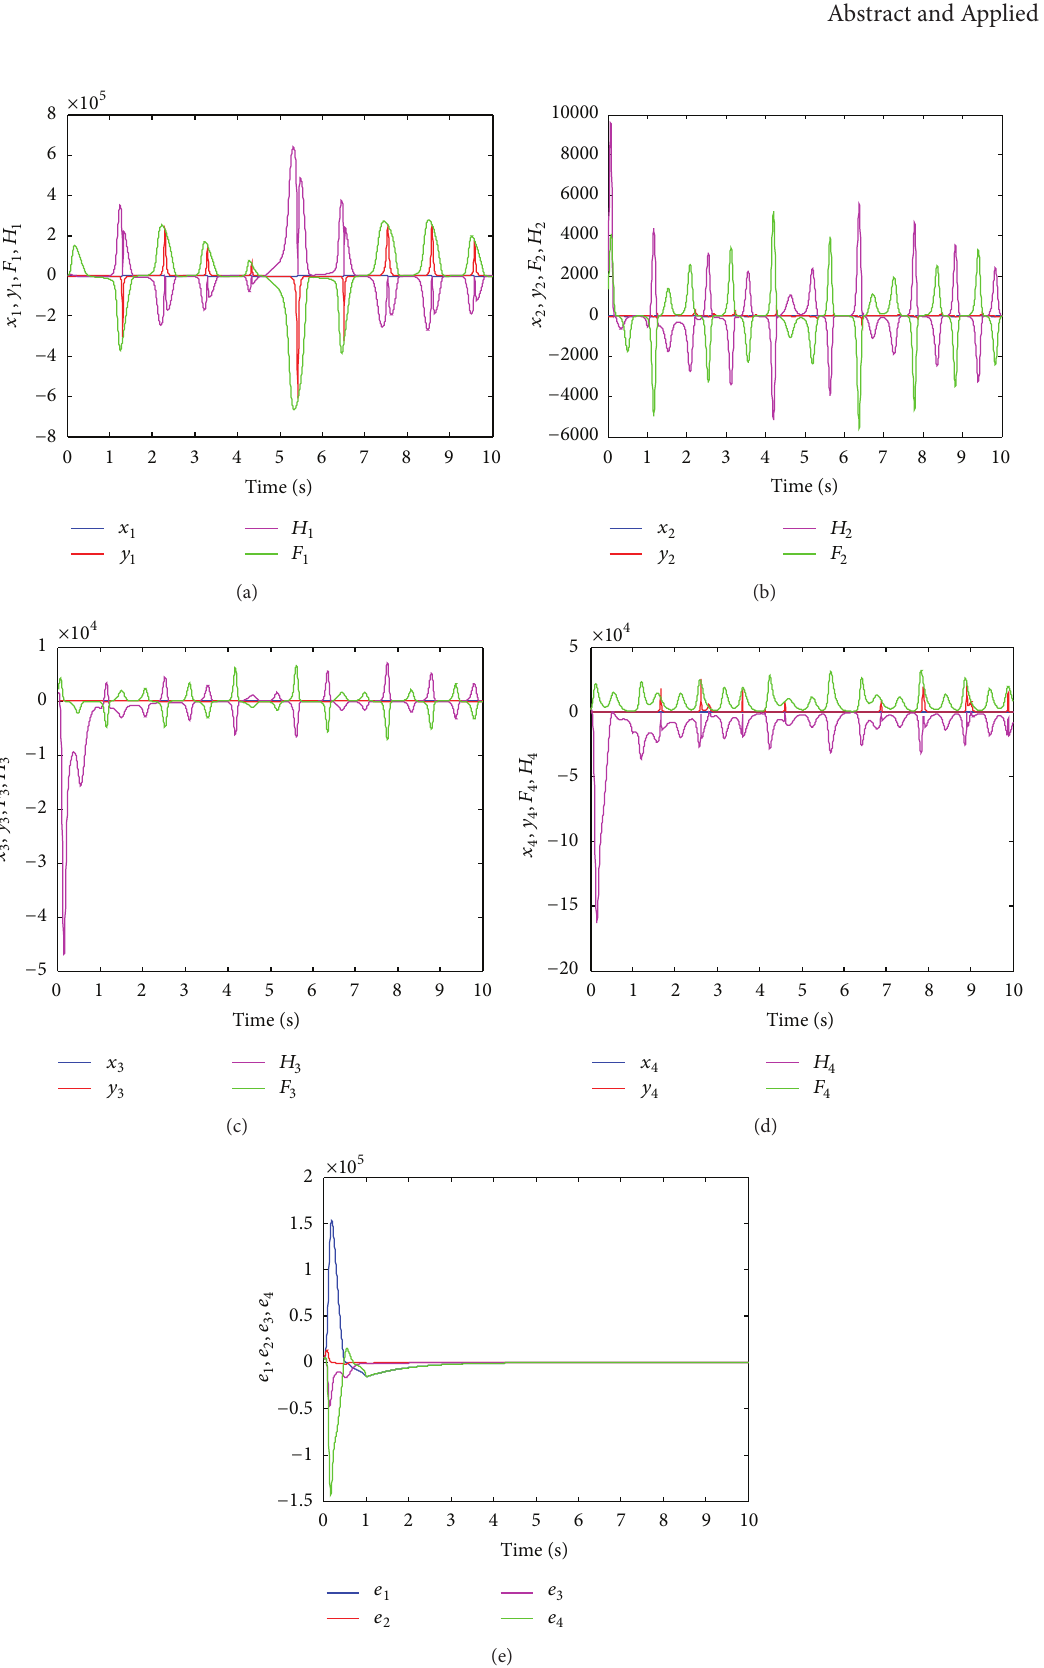
Figure 3: Time histories of states, state errors, 𝐹 1 , 𝐹 2 , 𝐹 3 , 𝐹 4 , 𝐻 1 , 𝐻 2 , 𝐻 3 , and 𝐻 4 for Case